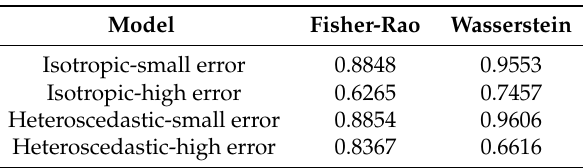
Table 1. Adjusted-Rand